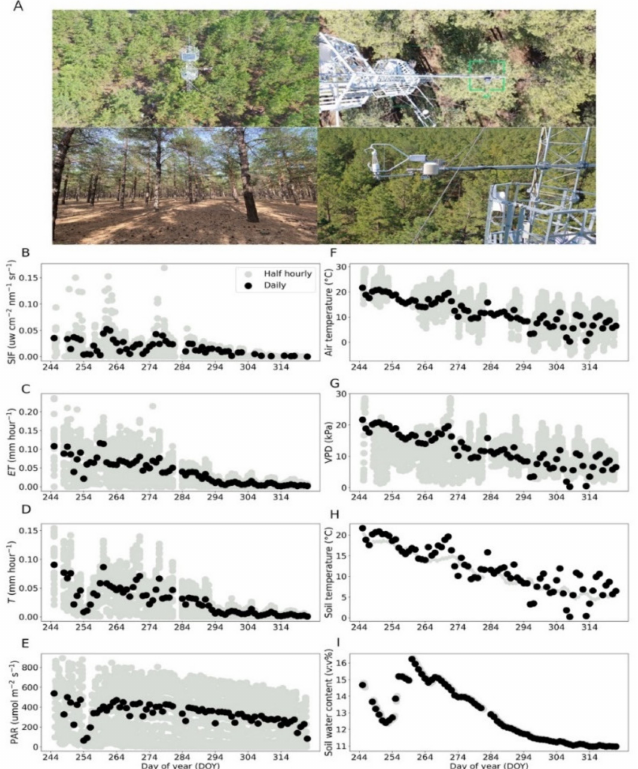
Figure 1. Images of the fluxes site where the canopy data were collected in fall season ( A ). Canopy- observed SIF, ET, T, PAR, air temperature, VPD, soil temperature and soil water content ( B – I ). Grey circles indicate half-hourly data, whereas black circles represent daily mean